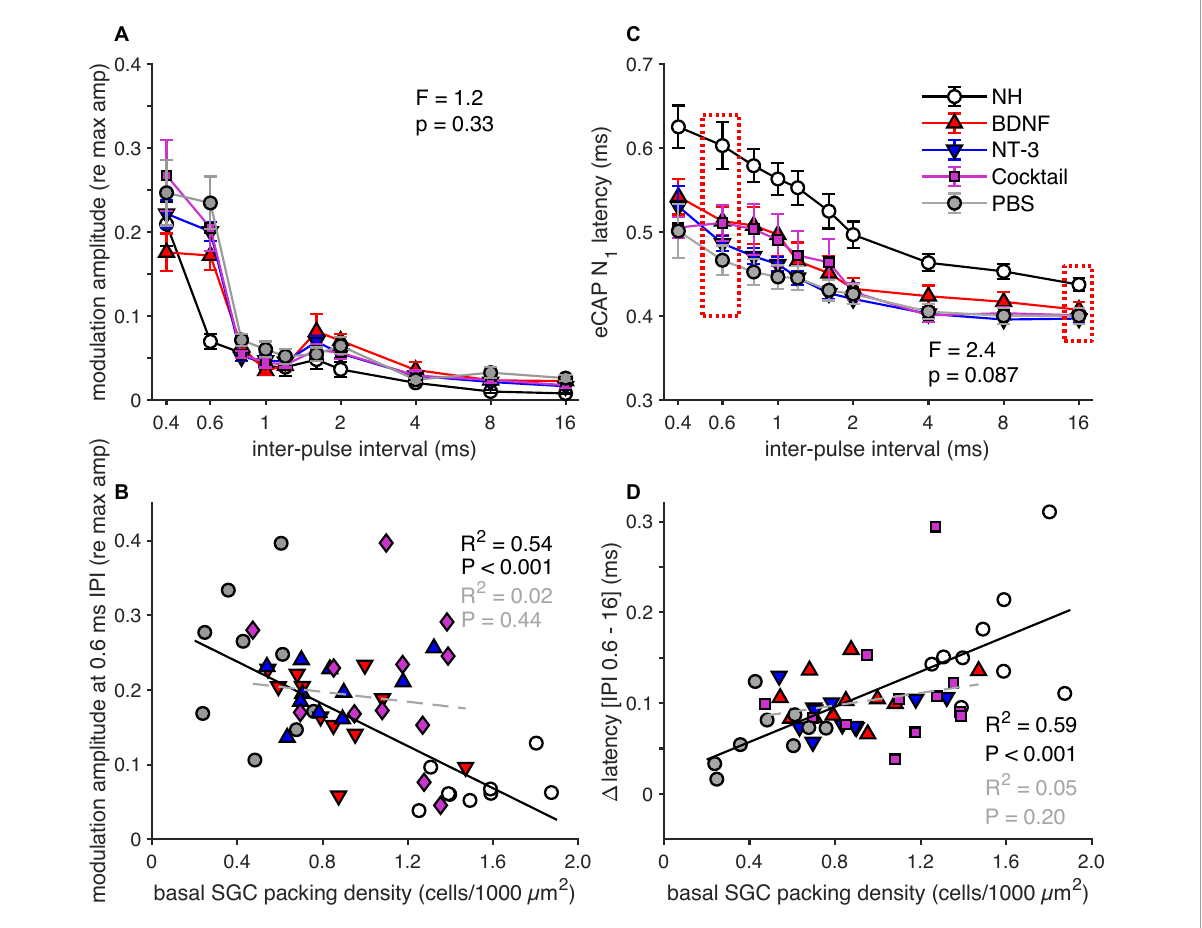
FIGURE8 eCAP parameters derived from the responses to the first ten pulses in a pulse train. (A) Group means of the normalized eCAP amplitude modulation, of the last six of the ten pulses, as function of IPI. (B) Group means of eCAP N 1 latency of the last six of the ten pulses, as function of IPI. (C) Amplitude modulation for an IPI of 0.6 ms for all individual animals as a function of basal SGC packing density, regression was calculated on the NH and PBS animals (black line) and on the neurotrophin-treated animals (gray line). (D) (cid:49) N 1 latency between 0.6 and 16 ms, for the individual animals as a function of SGC packing density. The regression was calculated on the NH and PBS animals (black line) and on the neurotrophin-treated animals (gray line). NH, n = 9; PBS, n = 9; BDNF, n = 11; NT-3, n = 11; Cocktail, n = 12. Error bars represent SEM.